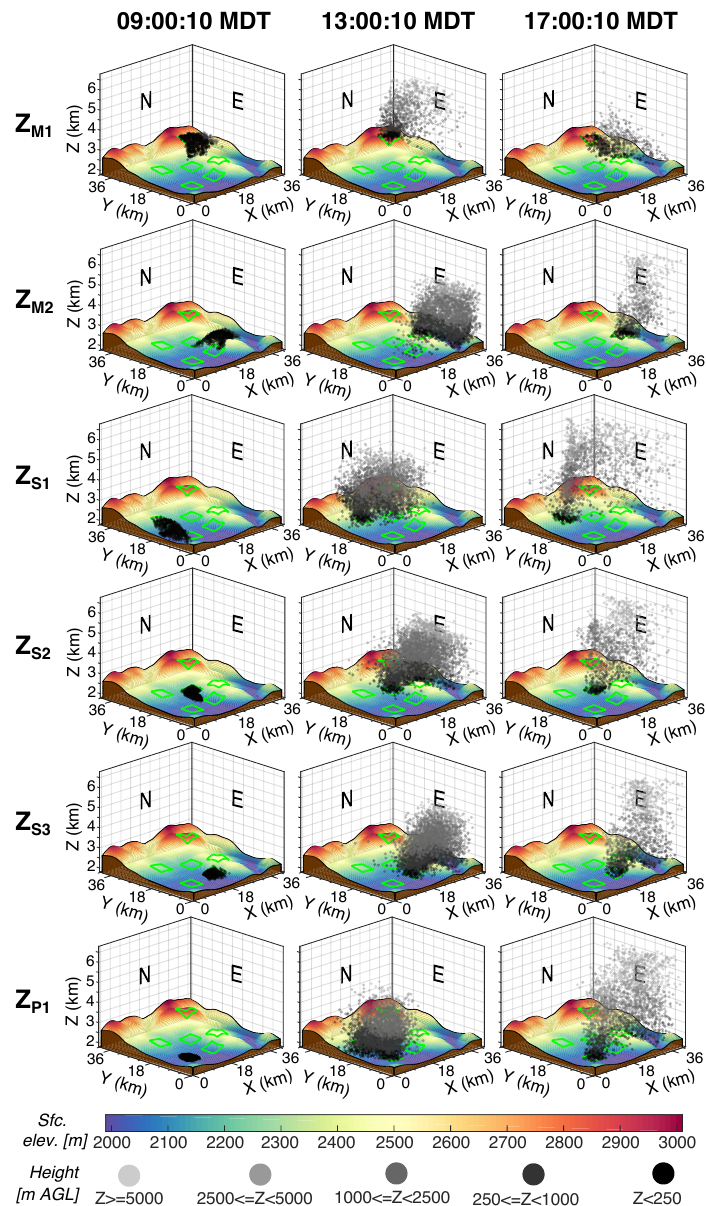
Figure 8. Visualization of six PM2.5 “plumes” created by isolating particles released from each analysis zone, from a viewing position southwest of the plumes, with zones organized by terrain characteristics (Mountain, Slope, Plains). Surface elevation (m above mean sea level) is indicated by shading of the three-dimensional ground surface, and particle height (m AGL) is indicated by marker color; see legends at bottom of figure. Analysis zones are indicated with green polygons. Three times are displayed, spanning the period from ( left ) 09:00:10 MDT to ( right ) 17:00:00 MDT, with a 4-h interval between